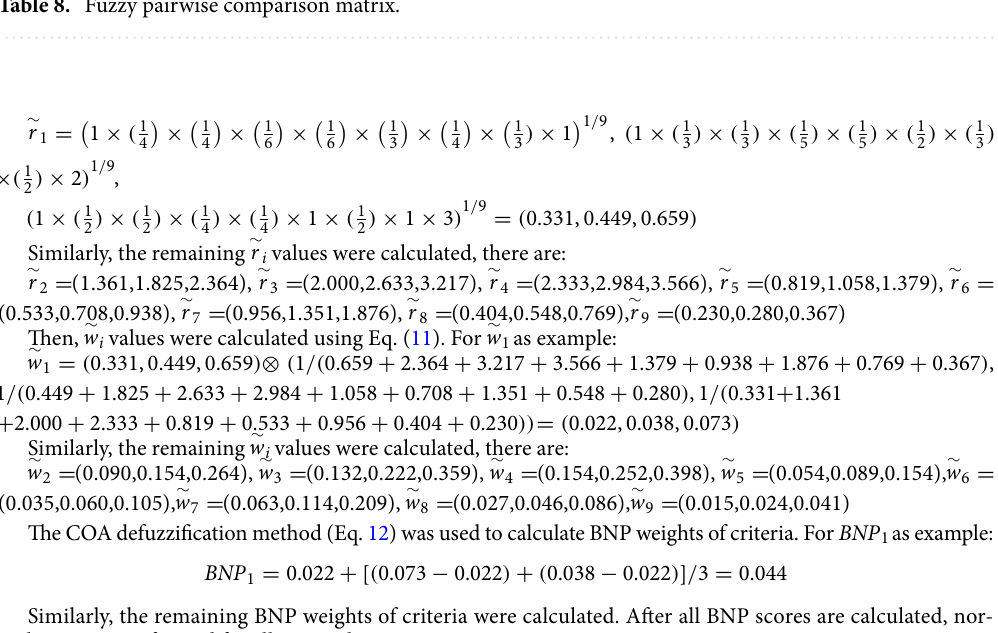
Table 8. Fuzzy pairwise comparison